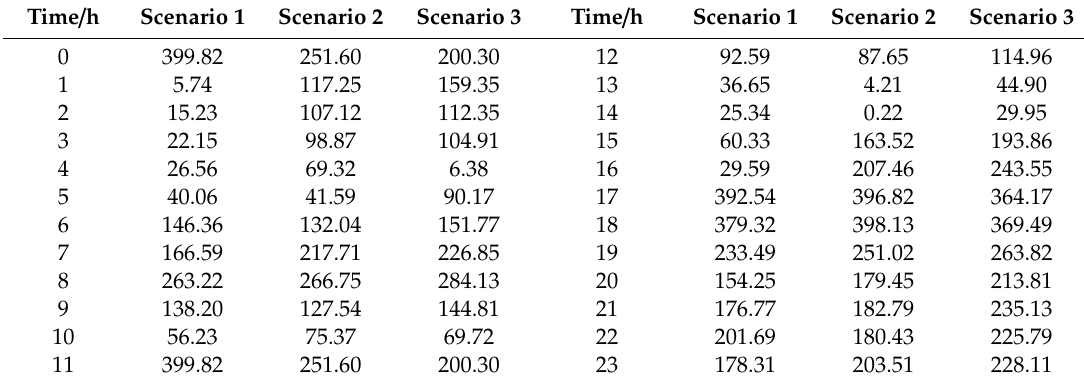
Table 3. Wind power accommodation by same electric load at di ff erent time (kW).